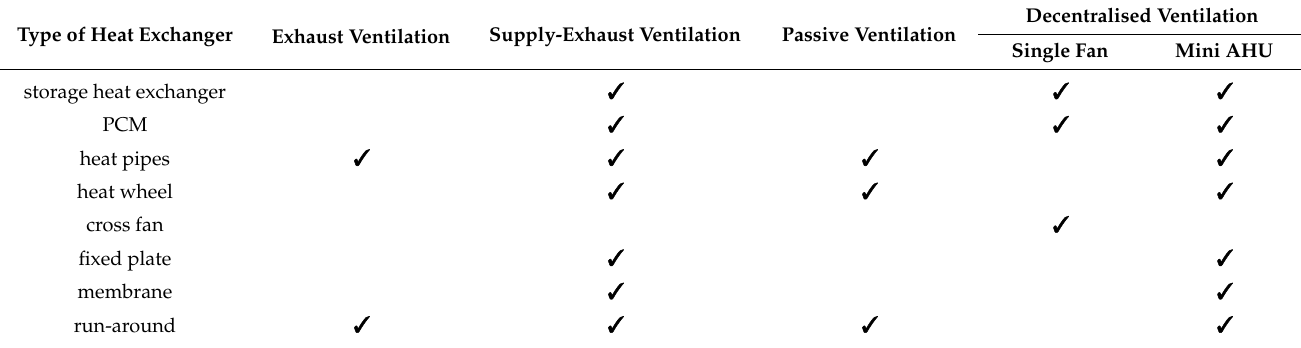
Table 3. The use of the heat recovery in various ventilation systems.